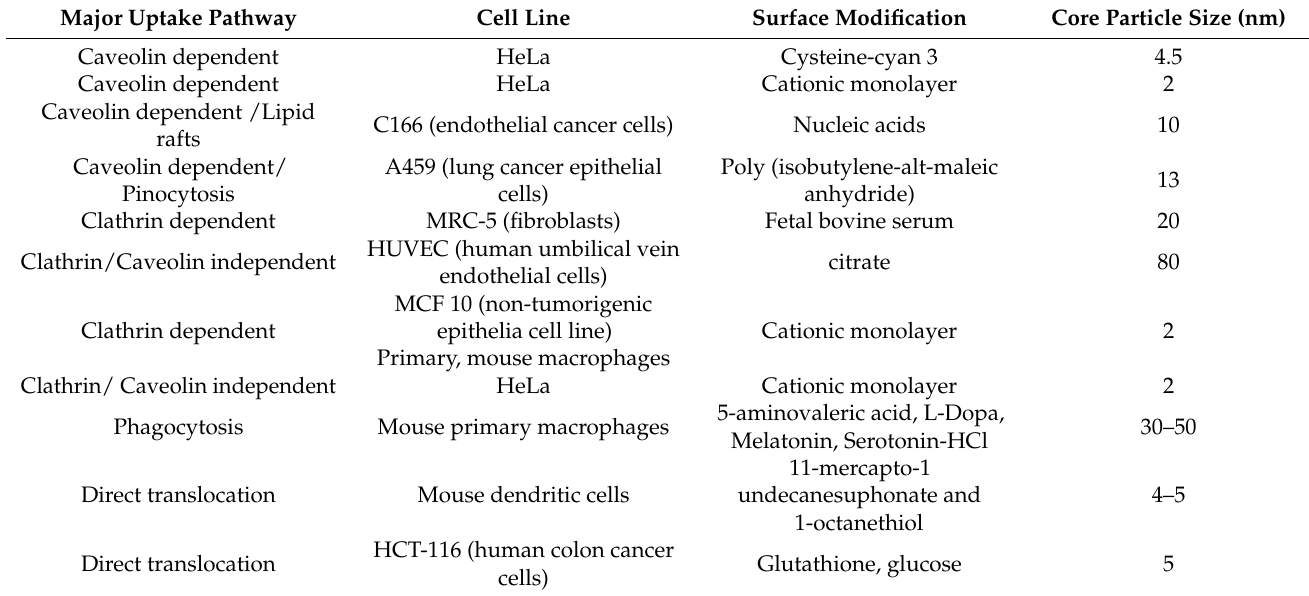
Abbreviations: HeLa: human cervical cancer cells, C166: mouse endothelial cells, A549: adenocarcinoma human alveolar basal epithelial cells, MRC-5: human lung fibroblasts, HUVEC: human umbilical vein vascular endothelium cells, HCT-116: human colorectal